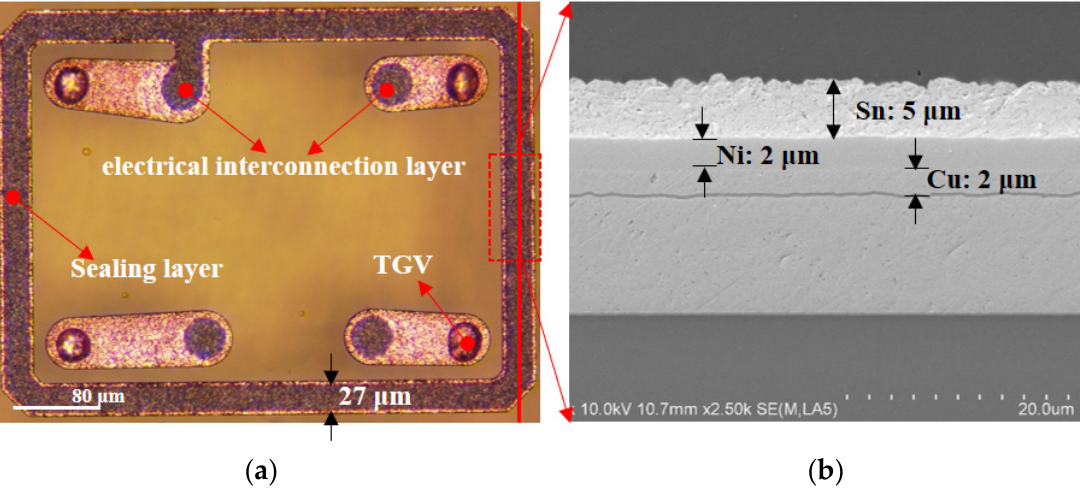
Figure 10. ( a ) The Cu/Ni/Sn (2/2/5) bonding layer is patterned. ( b ) The SEM micrography of a cross-section image of Cu/Ni/Sn bonding layer, which shows the thickness of plating Sn is 5 μ m.